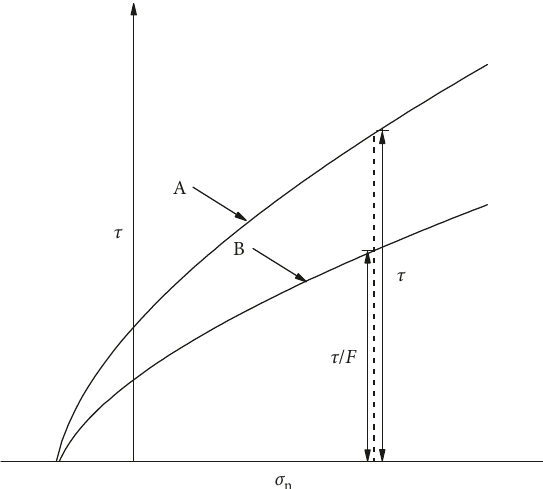
Figure 2: Lowering of equivalent shear-normal